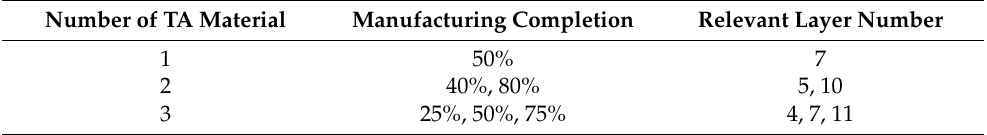
Table 4. Configuration of three-point flexural testing